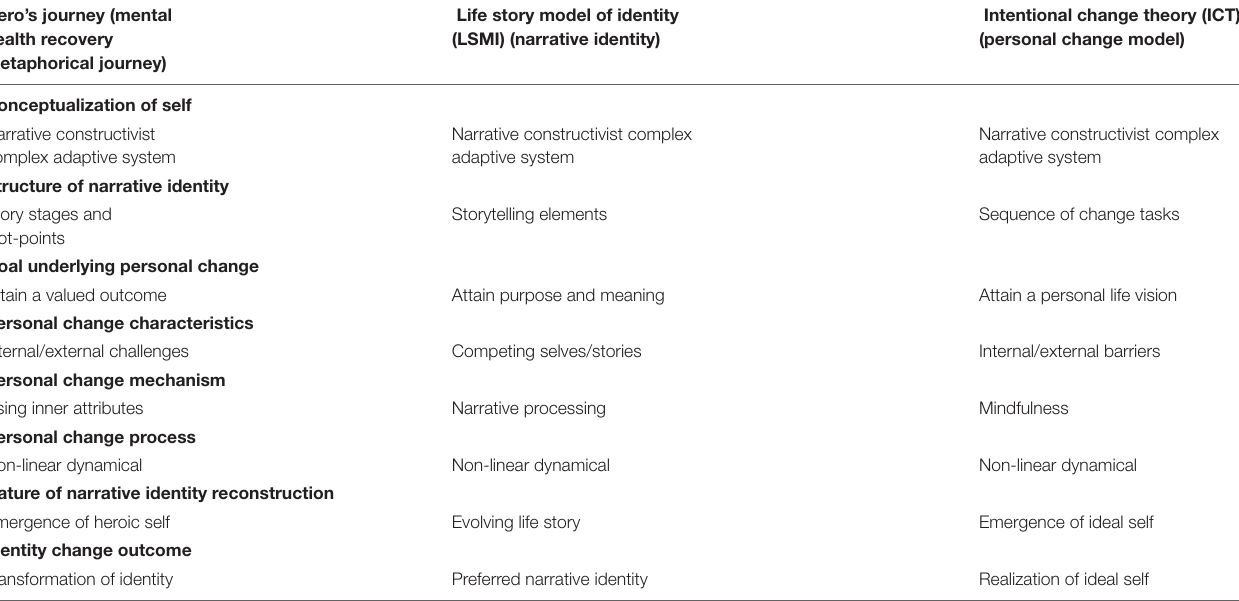
TABLE 1 | Alignment between theories and models in an integrative conceptual framework for narrative identity reconstruction in mental health recovery. Hero’s journey (mental health recovery metaphorical